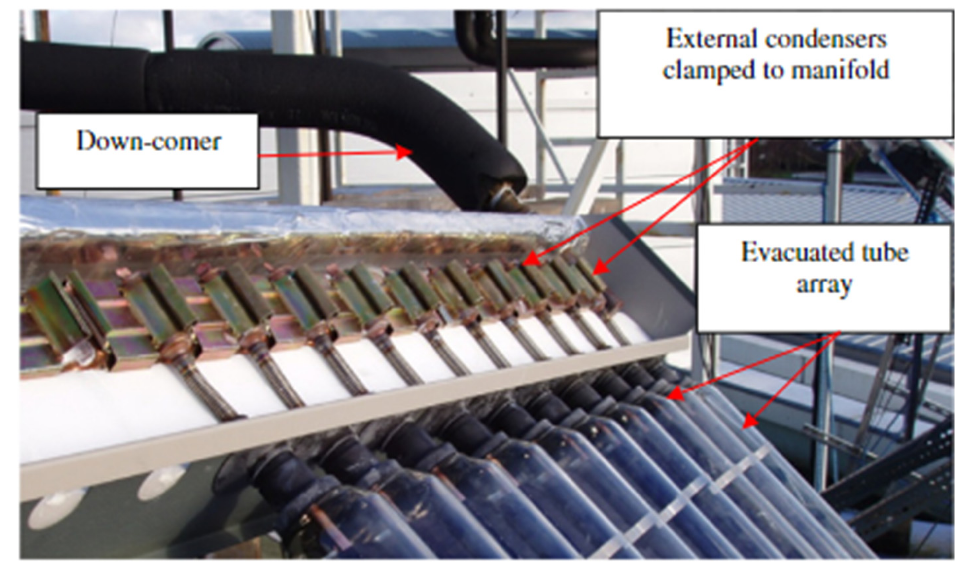
Figure 11. The external heat pipe condensers in a comparison study in the United Kingdom. Adapted with permission from ref. [91] 2012 Redpath.